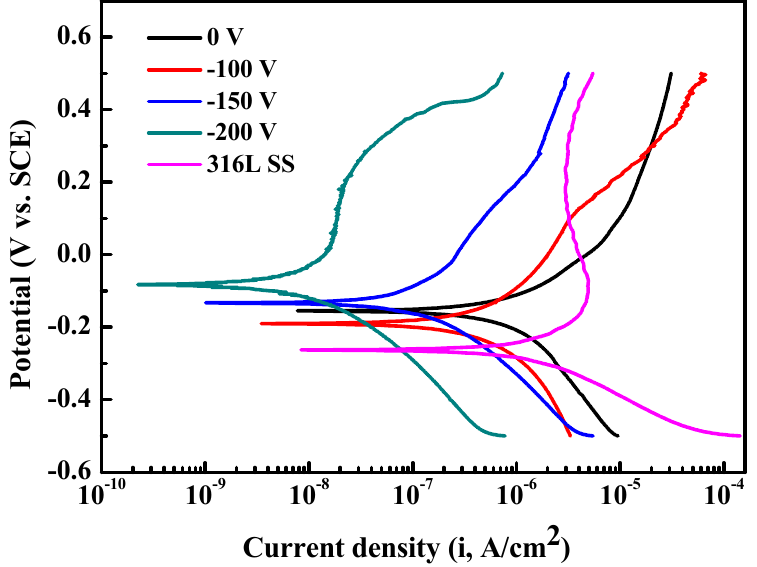
Figure 9. Potentiodynamic polarization curves of 316L SS and HfC coatings deposited at different bias voltages: ( a ) 0 V, ( b ) − 100 V, ( c ) − 150 V, ( d ) − 200 V, and ( e ) AISI